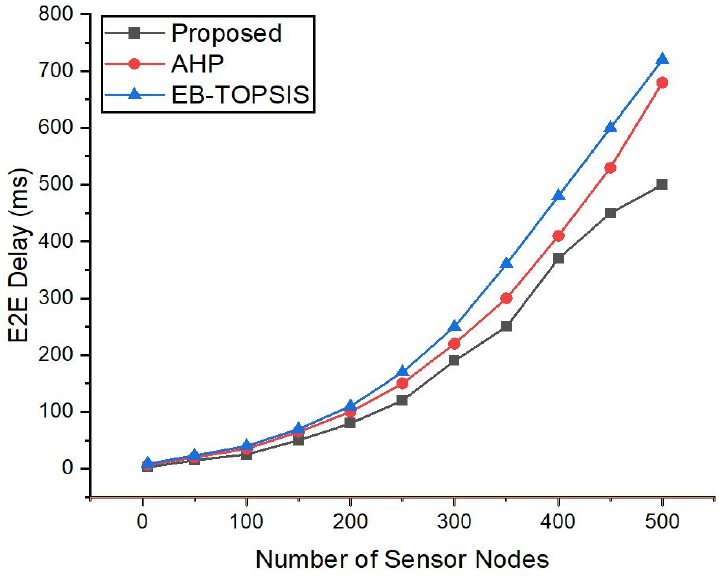
Figure 4. Delay recorded with increasing the number of sensor nodes.